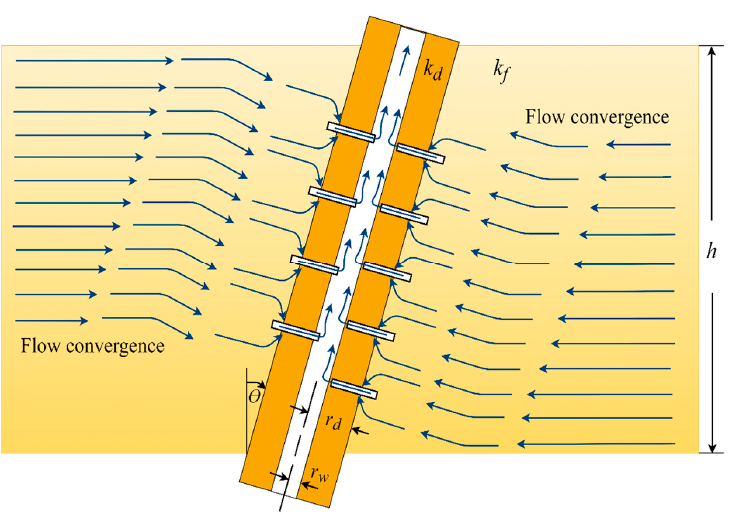
Figure 2. Schematic of inclined and completely perforated well with perforations perpendicular to well and formation damage.